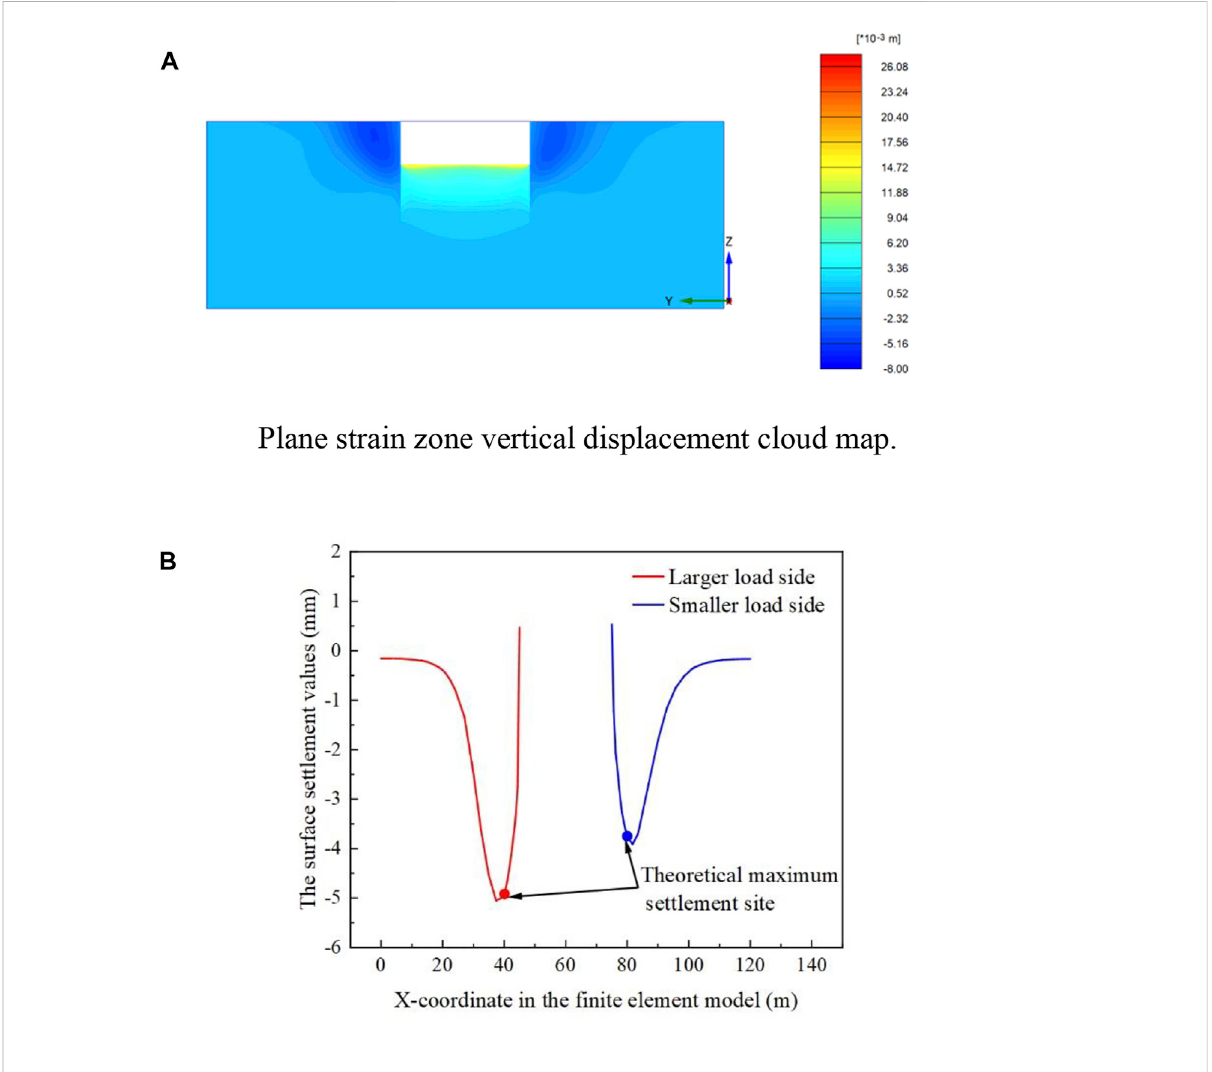
FIGURE 8 Vertical deformation under 0:20 kPa condition. (A) Plane strain zone vertical displacement cloud map. (B) Surface settlement pro fi le after the diaphragm wall in the plane strain